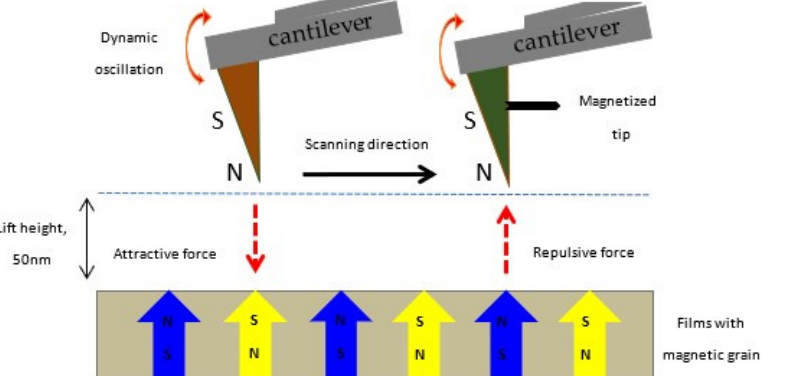
Figure 7. Schematic process for MFM image of ZnO-based DMS films. The appearance of magnetization in films, as well as in the probing tip, is represented by the magnetic poles: North (N)—up and South (S)—down.